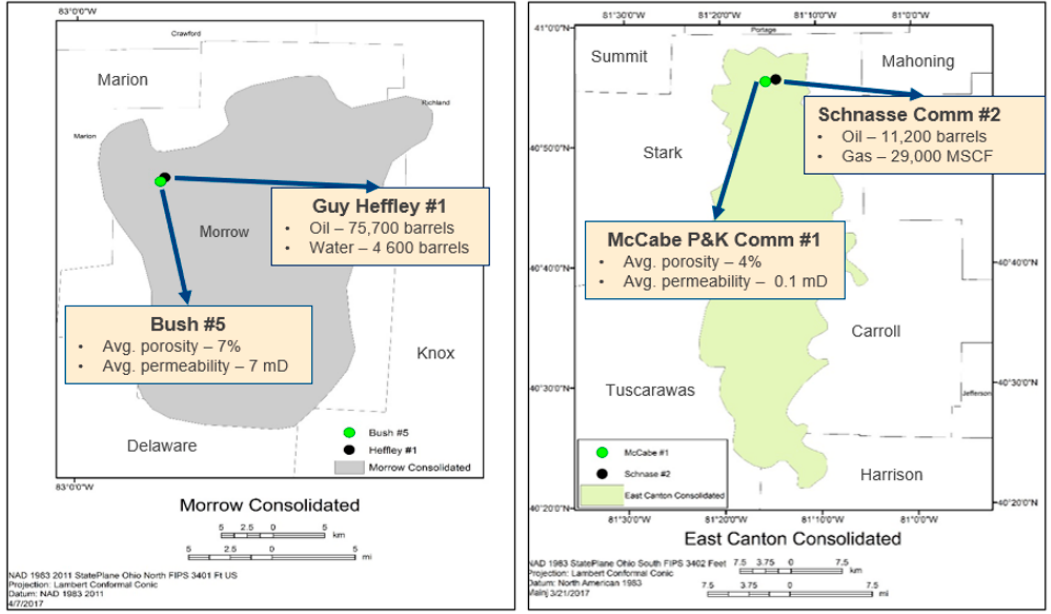
Figure 3. Locations of wells used for sampling in Morrow Consolidated oilfield (MCOF) ( left ) and East Canton oilfield (ECOF) ( right ).